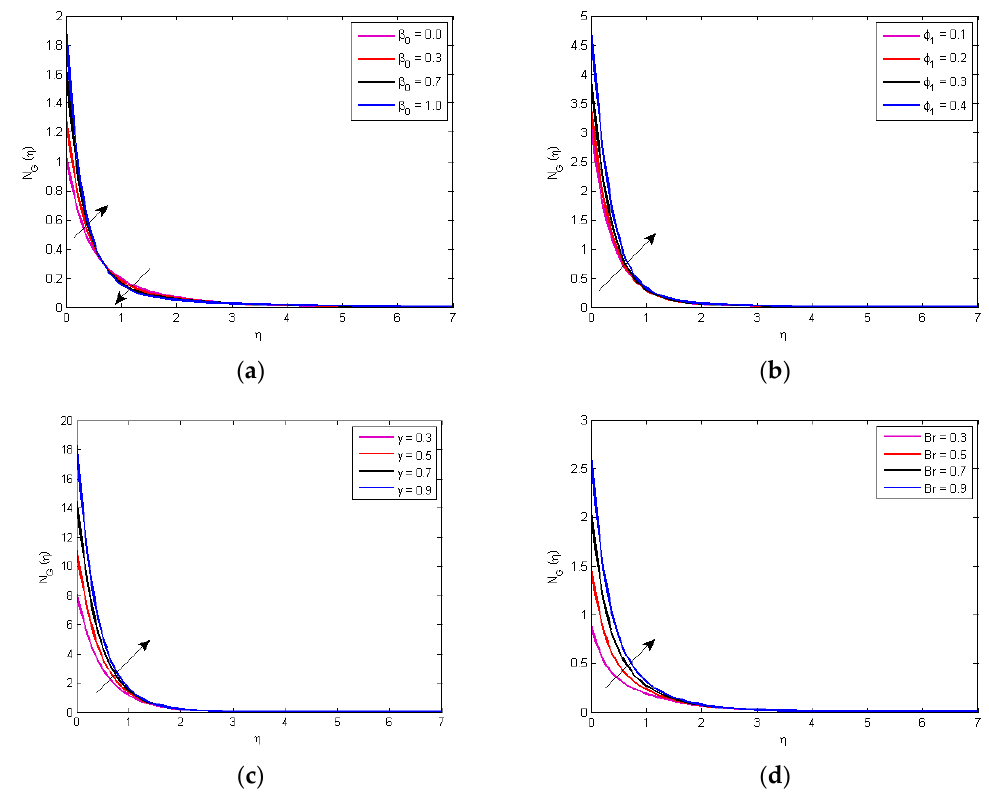
β φ γ , ( b ) is 1 , ( c ) is , ( d ) is